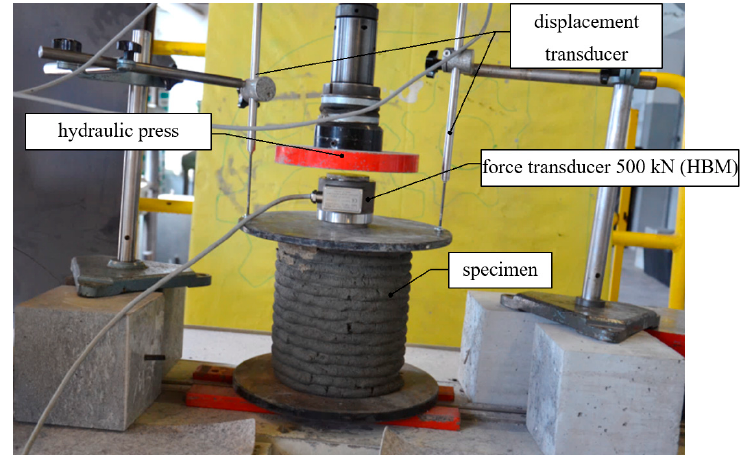
Figure 4. Test stand for compressive strength evaluation of printed structures.